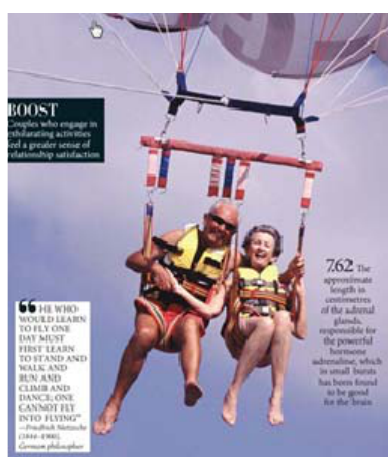
Vassoss, V. Zoomer Magazine 07/2012, p.